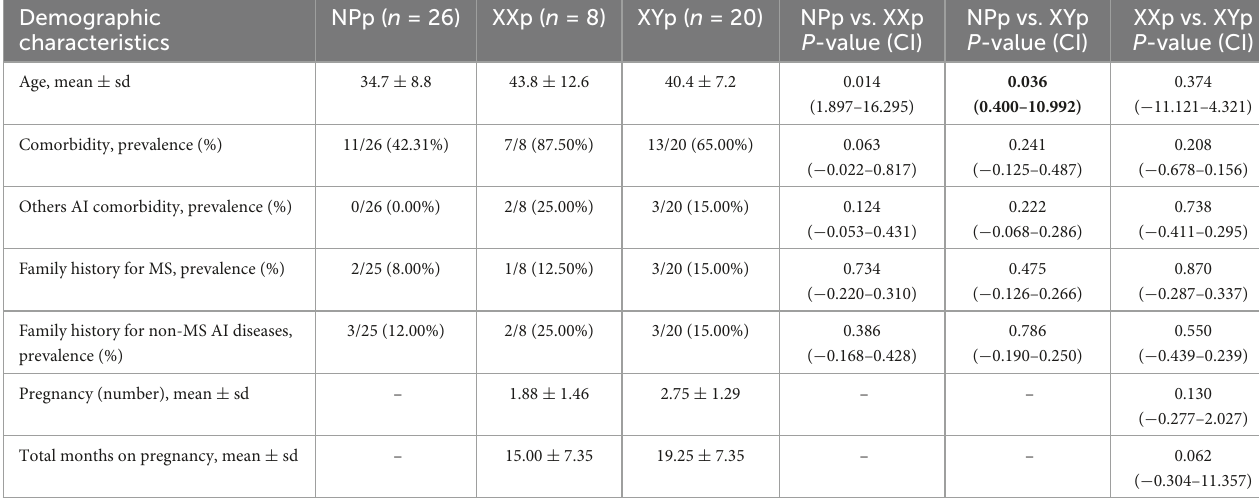
TABLE 2 Demographic characteristics at